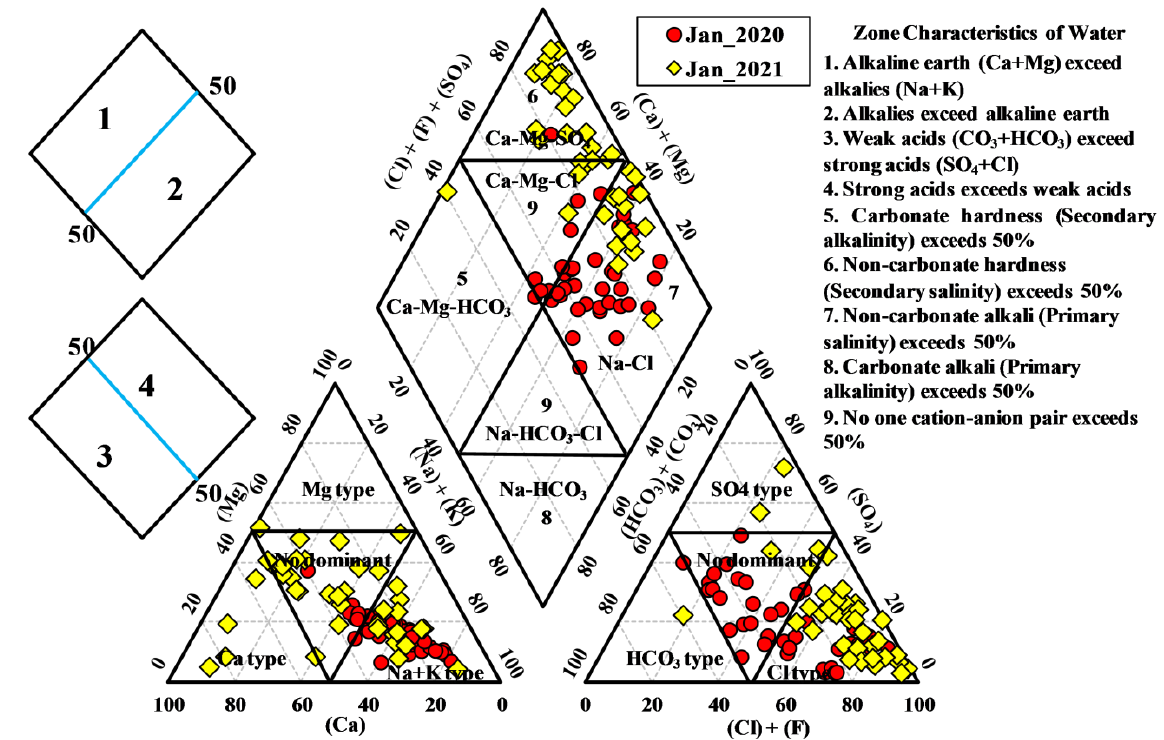
Figure 8. Piper’s plot for the hydrogeochemical facies determination.